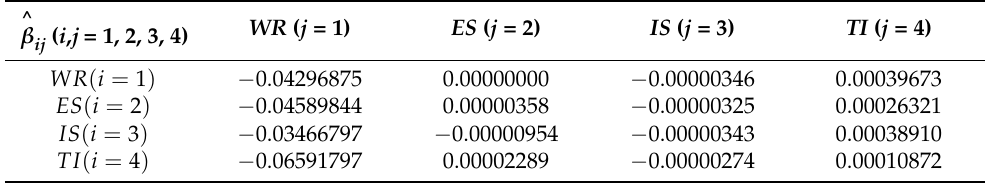
Table 9. GLV model related parameters of forecast data in Beijing area.